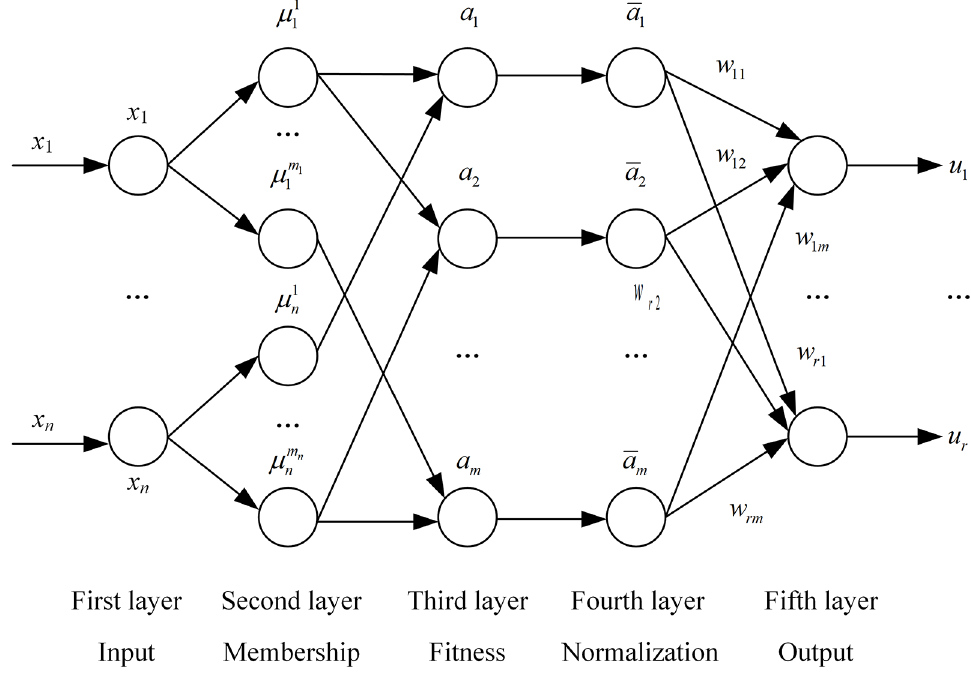
Fig. 15. Fuzzy neural network structure diagram based on the Mamdani